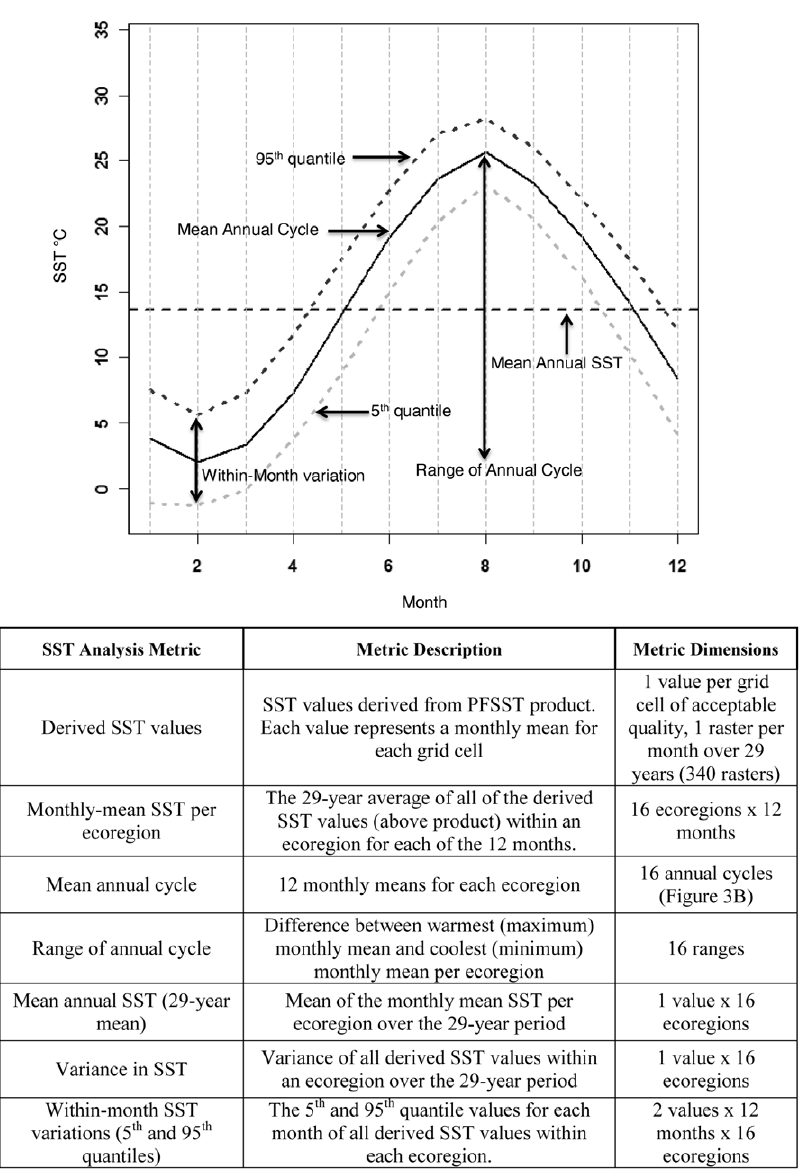
Figure 2. Annual cycle metrics analyzed in this study. Generalized illustration and tabular description of metrics used to evaluate the annual SST cycle in the North Pacific ecoregions. Individual, ecoregion-specific annual cycles are depicted in Figure 3.